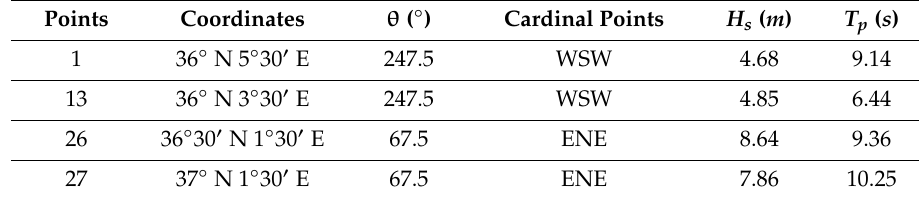
Table 4. H s and T p wave parameters in the lateral boundary of the numerical domain for T r = 50 years. Points Coordinates θ ( ◦ ) Cardinal Points H s ( m )